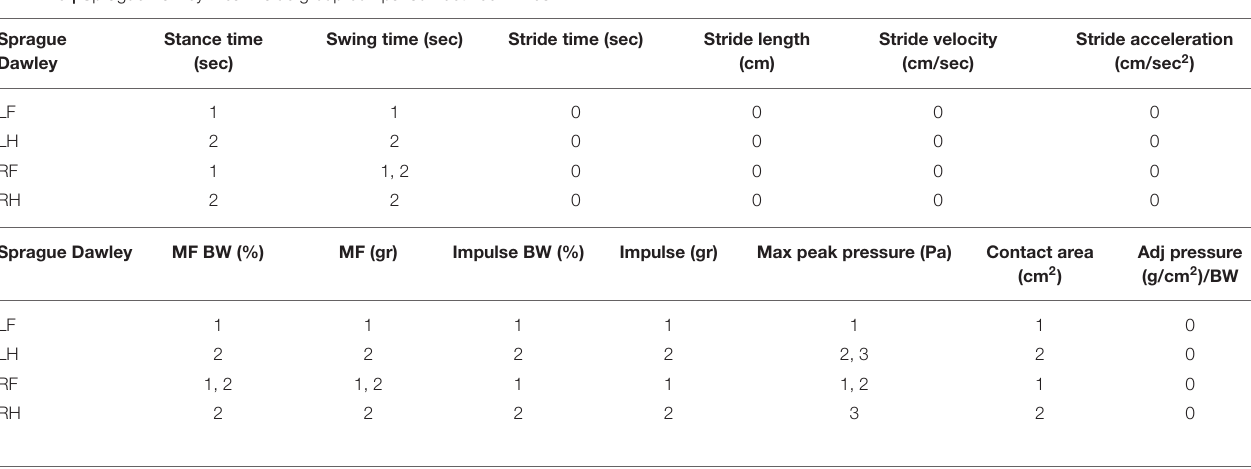
TABLE 6 | Sprague Dawley mean value group comparison between